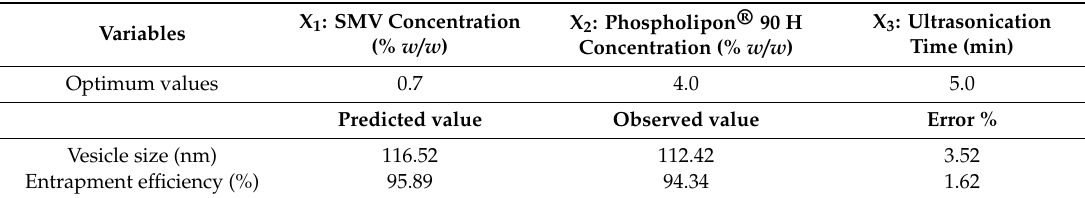
Optimized variables levels of the optimized SMV-EMLs and its predicted and observed responses.